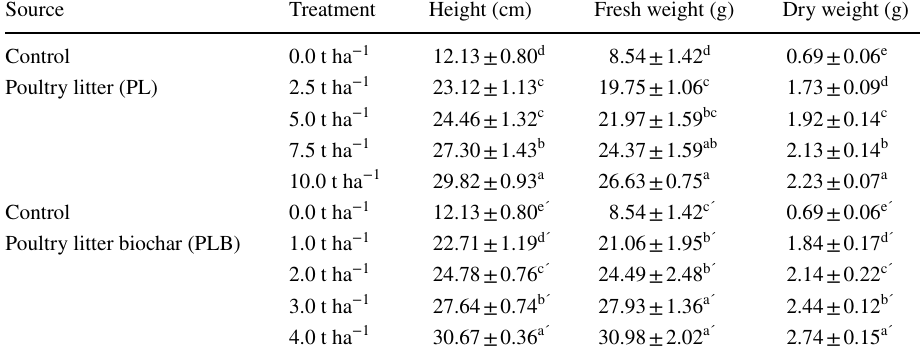
Data represent the average ± the standard deviation ( n